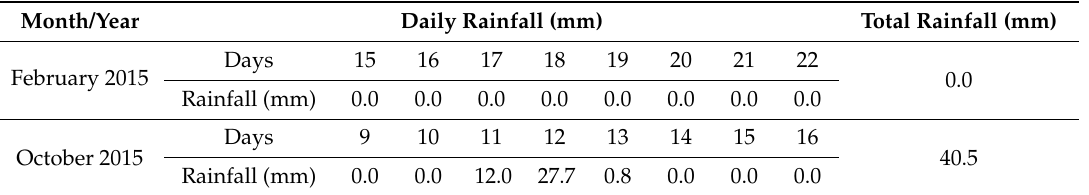
Table 3. Precipitation data on the day and seven days prior to the acquisition of SAR and optical data.